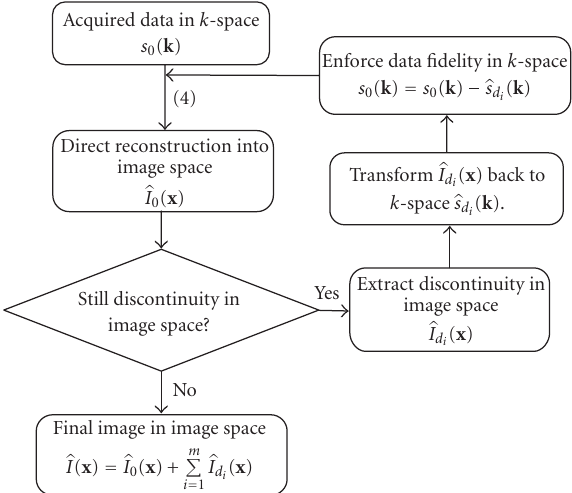
Figure 3: Flowchart of the discontinuity subtraction reconstruction algorithm.